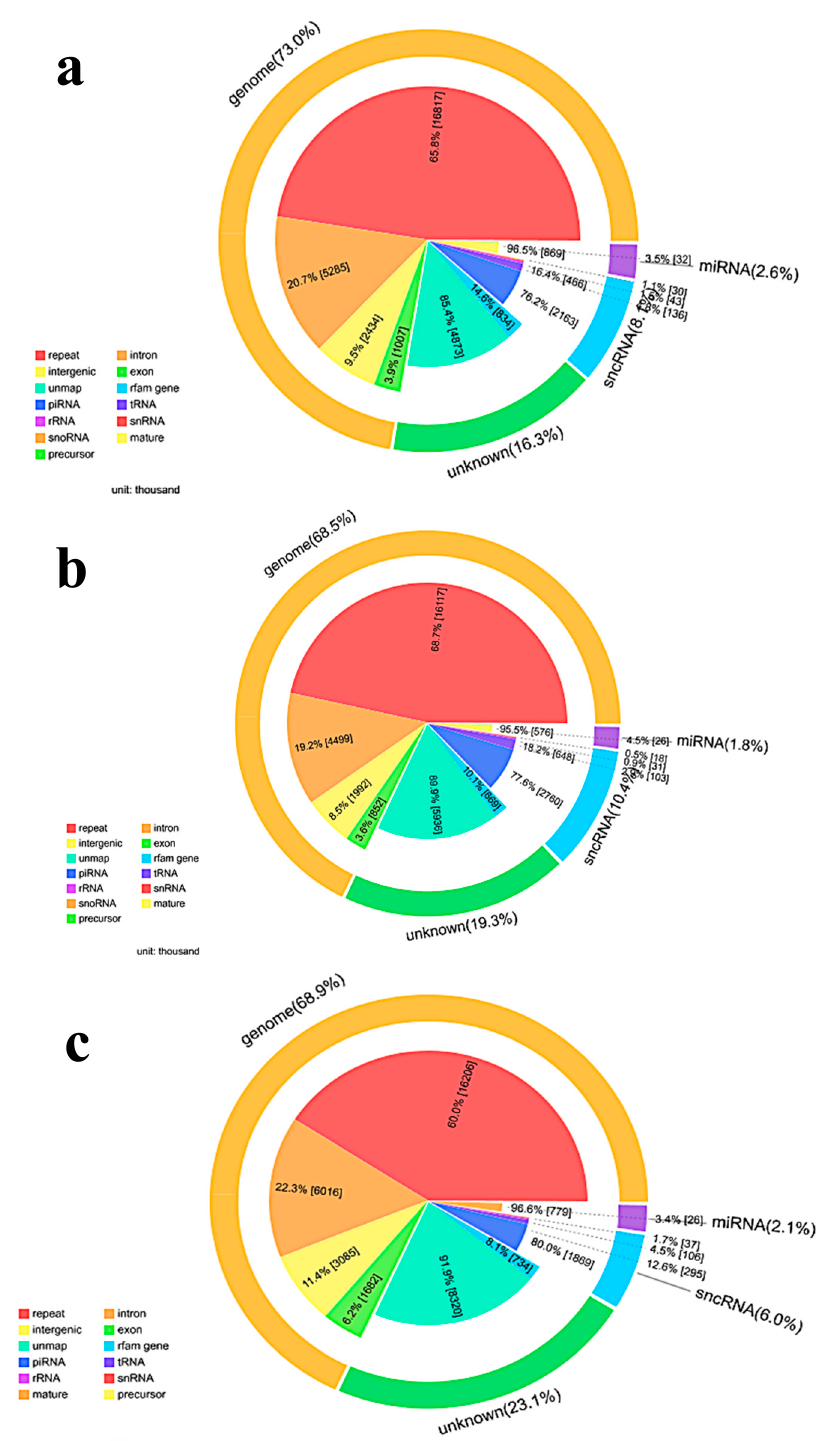
Figure 4. Proportion of small RNAs among different categories. To make every unique small RNA mapped to only one annotation, we follow the following priority rule: microRNA > piRNA > snRNA > Rfam > other RNAs. ( a ) Pie diagram for annotation of small RNA in control HCT116 cell lines (total for each category); ( b ) Pie diagram for annotation of small RNA in TiO 2 -NPs-3 µ g / mL treated HCT116 cell lines (total for each category); ( c ) Pie diagram for annotation of small RNA in TiO 2 -30 µ g / mL treated HCT116 cell lines (total for each category).